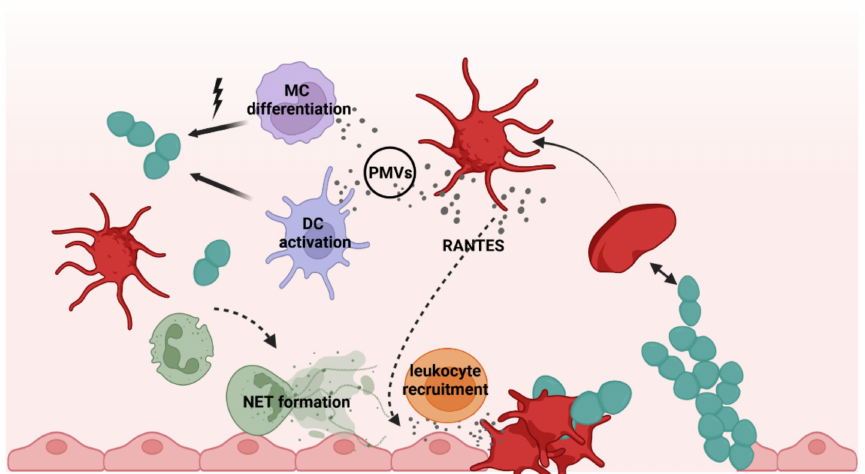
Figure 1. Scheme illustrating different platelet functions in the immune response. Platelets sense and bind invading bacteria and injured endothelium, resulting in platelet activation. Upon activation, platelets release chemokines and cytokines such as RANTES, triggering leukocyte recruitment and PMVs acting on gene expression of monocytes and monocyte (MC)-derived cells such as dendritic cells (DC). In addition, neutrophils are attracted, and NET formation occurs at the site of infection via platelet-dependent mechanisms. Created with BioRender.com (accessed on 21 March